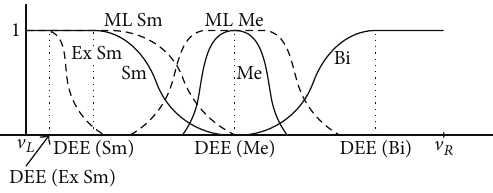
Figure 2: Shapes of extensions (fuzzy sets) of evaluative linguistic expressions. DEE denotes the defuzzified values obtained using the Defuzzification of Evaluative Expressions